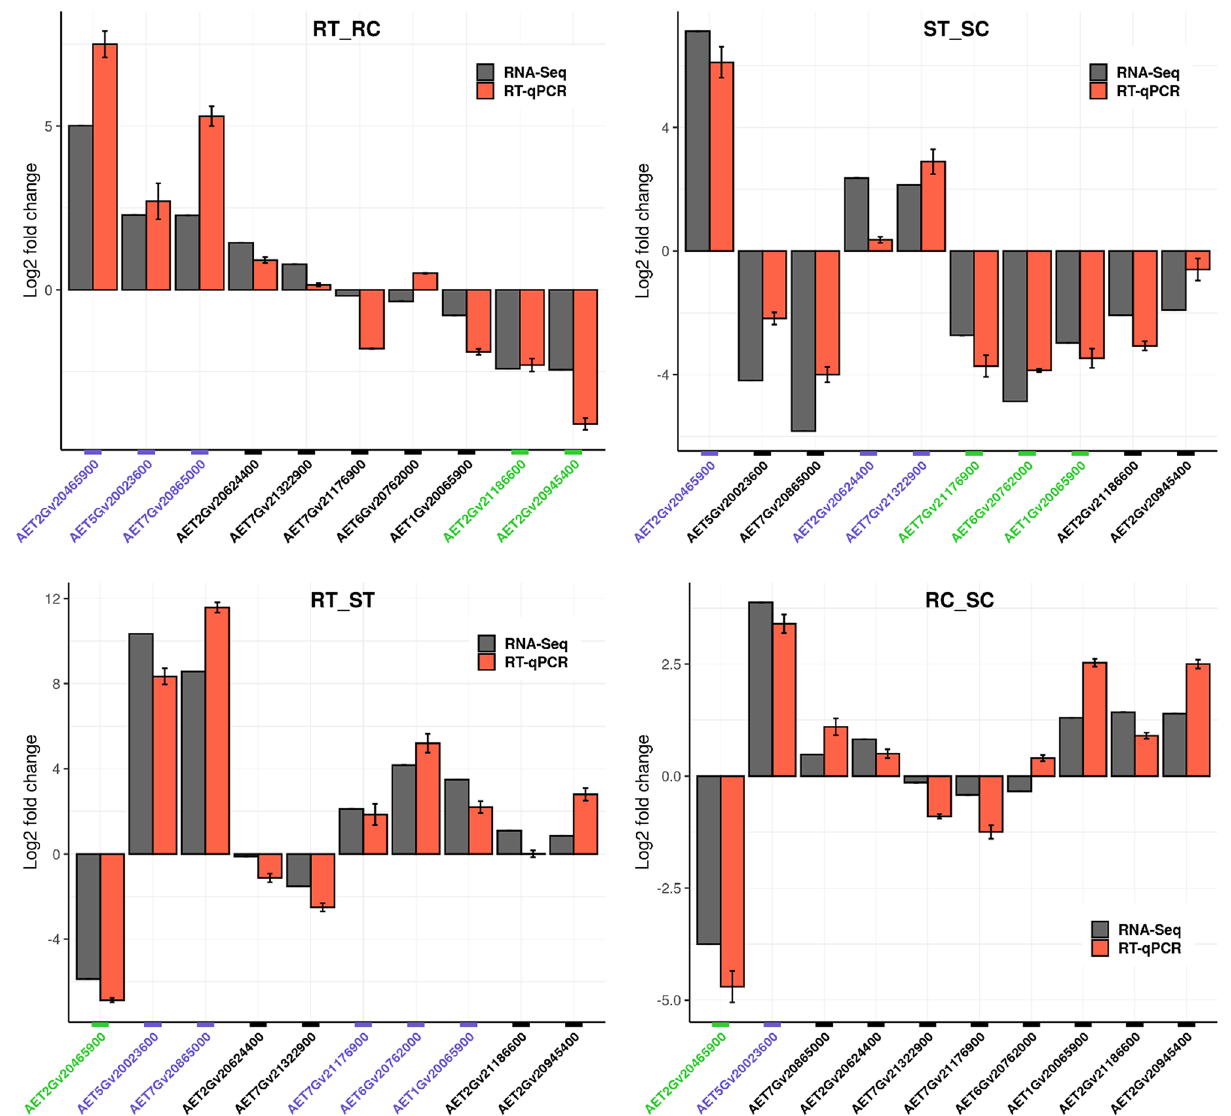
Figure 2. Illustration of the RT-qPCR confirming the results of 10 selected DEGs. The X axis represents the genes and the Y axis indicates the log 2 (fold-change) values derived from RNA-seq and RT-qPCR in all four comparisons. Purple, green and black colors show up-regulated, down-regulated and non-significant DEGs, respectively. RC (resistant control), RT (resistant treatment), SC (susceptible control), and ST (susceptible treatment). The bar plots were created using ‘ggplot2 version 3.3.5’ R/CRAN package (https:// ggplo t2. tidyv erse.